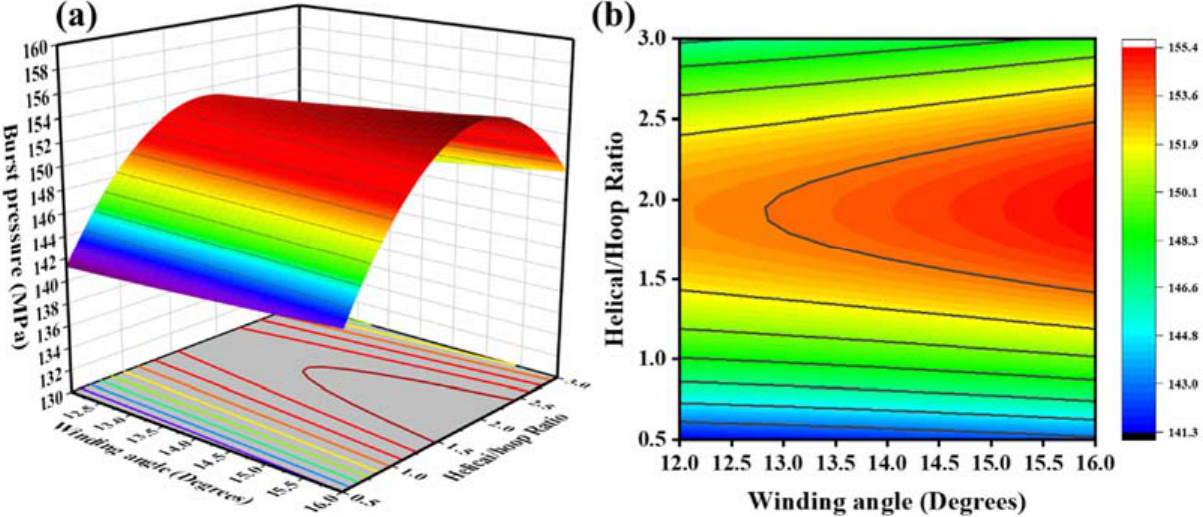
Figure 7. ( a ) Response surfaces of the effect of the helical/hoop ratio and the winding angle on blasting pressure; ( b ) contour plot of the effect of the helical/hoop ratio and the winding angle on blasting pressure.